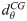
Schematic diagram of a phenomenological model to generate sequences of θ- and δ-burst durations with varied degree of anti-correlated coupling.(a) First, burst durations dθ and dδ are randomly drawn from the empirically obtained distributions (power law and Weibull, Fig 2) and separately ranked. Durations d = n * w are a multiple of the scale of analysis (window size w = 2 s). (b) Ranks of θ- and δ-burst durations are then paired to form an anti-correlated sequence: if the rank(dθ) of a θ-burst is large, than the rank(dδ) of the following dδ-burst is selected to be smaller, and vice versa. Repeating this process leads to a sequence of generated dθ and dδ durations with a certain degree of anti-correlation. (c) This newly generated anti-correlated time series is binarized, i.e. ‘+’/’-’ is assigned to each window w that belongs either to a dθ (red, ‘+’) or dδ (blue, ‘-’) duration, respectively. The binary time series is then coarse grained according to a majority rule applied over a window Δ = 5w. From the resulting coarse-grained (CG) binary series, consecutive θ durations, dθCG, and δ durations, dδCG, are extracted. Details of the model are given in Materials and methods: Model of anti-correlated burst coupling.